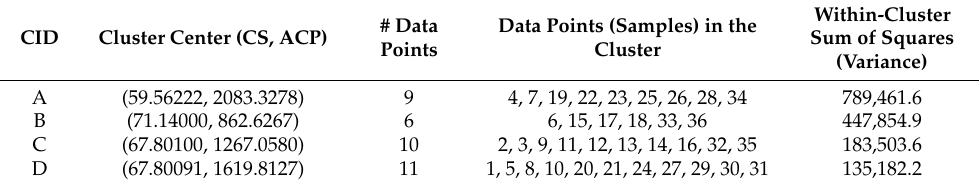
data points. The centers of these clusters were located at ( CS , ACP ) = (59.56222, 2083.3278), (71.14000, 862.6267), (67.80100, 1267.0580), and (67.80091, 1619.8127), respectively. The within-cluster sum of squares (SS) was 789461.6, 447854.9, 183503.6, and 135182.2, respec- tively. The subtotal of the within-cluster SSs accounted for 88.8% of the total SS. Table A7 provides a summary of the clusters. Table A7. Clusters of the tested